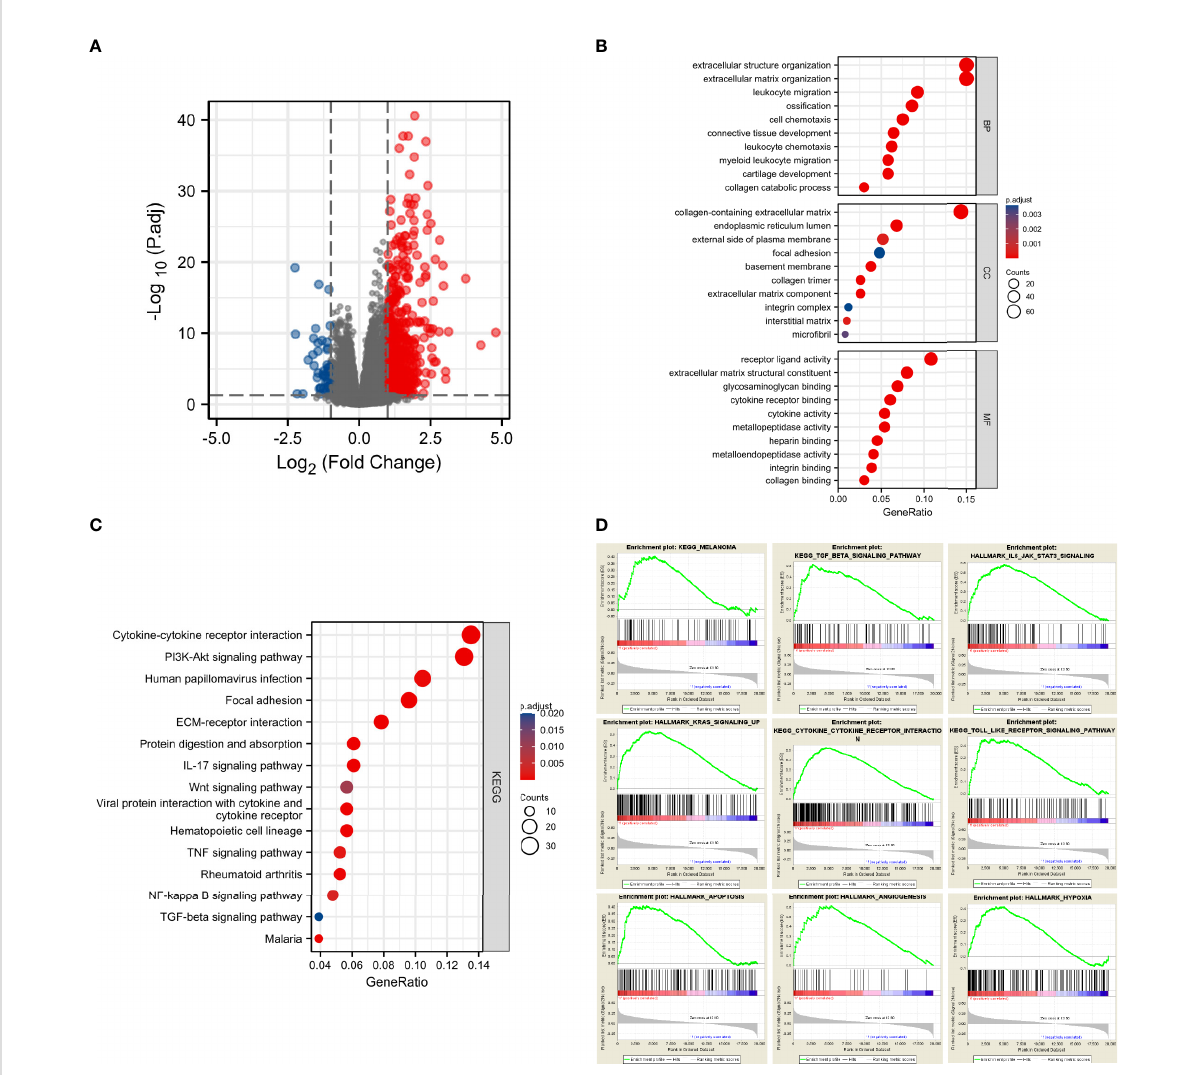
FIGURE 3 CD73 expression was markedly associated with tumorigenesis and tumor immunity. Signi fi cantly altered genes in CD73 high tumor shown on volcano plot (A) ; Bar plots displayed the top 10 BP, MF and CC terms substantially correlated with CD73, and most of them were tumor-related and immune-related (B) ; The bubble plot showed the top 15 KEGG terms substantially correlated with CD73, and they were also tumor-related and immune-related (C) ; The results of GSEA revealed that most of the CD73-related pathways were related to tumorigenesis and activation of immune response (D)